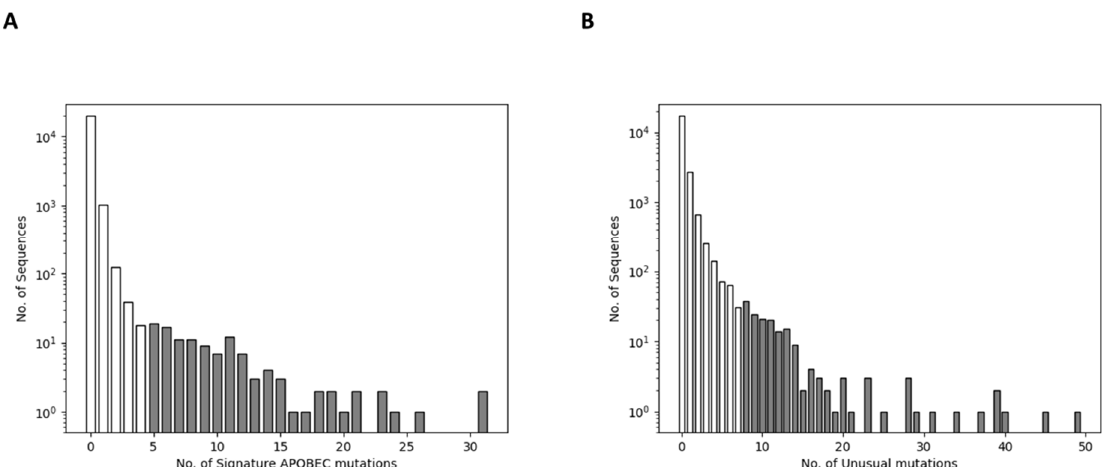
Figure 1. The distribution of the number of signature APOBEC mutations per sequence ( A ) and the number of unusual mutations (defined as having a global prevalence <0.1%; ( B )) per sequence in the approximately 21,000 published HIV-1 Group M capsid sequences from individuals with active virus replication. Sequences containing ≥ 5 signature APOBEC mutations or ≥ 8 unusual mutations, indicated by grey histograms, were considered to belong to a distribution of sequences with an increased risk of sequence artifact by expectation maximization.